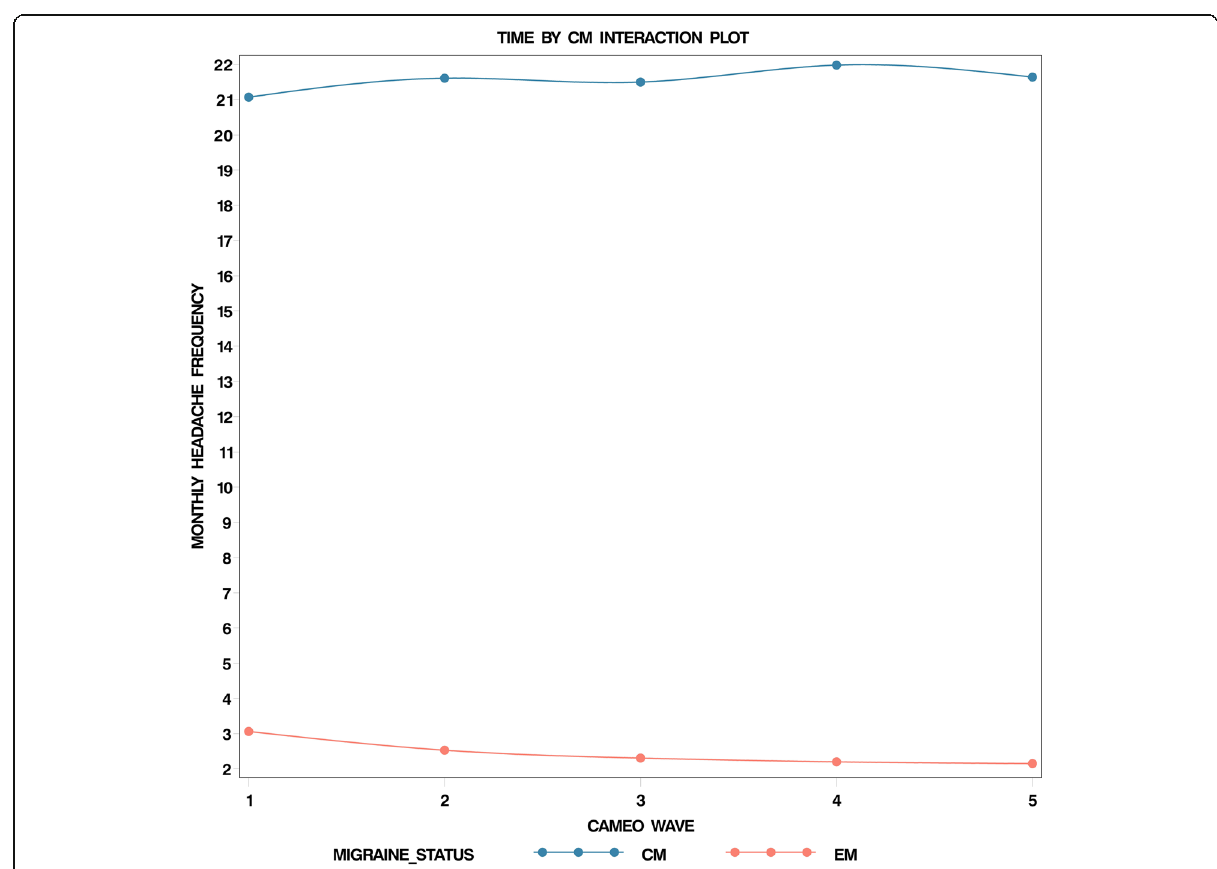
Fig. 4 Episodic- and chronic migraine-specific longitudinal trajectories. Time by chronic migraine interaction